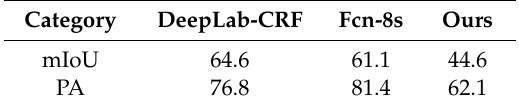
Table 3. We compare the fraction of pixel level semantically segmented mIoU and pixel accuracy (PA).